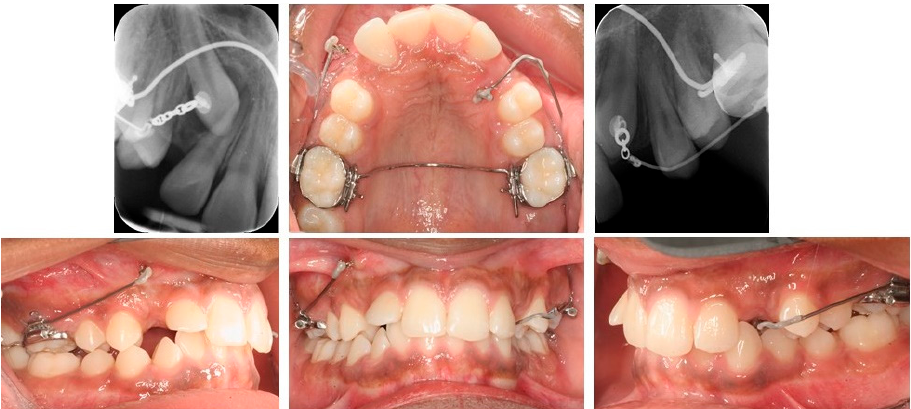
Figure 4. Bilateral canine impaction: ( right ) buccal and ( left ) palatal. Right maxillary canine: traction with 0.017 × 0.025 (cid:48)(cid:48) TMA cantilever activated for extrusion. Left maxillary canine: can- tilever is inserted into the auxiliary tube of an upper molar, activated for canine extrusion and buccal